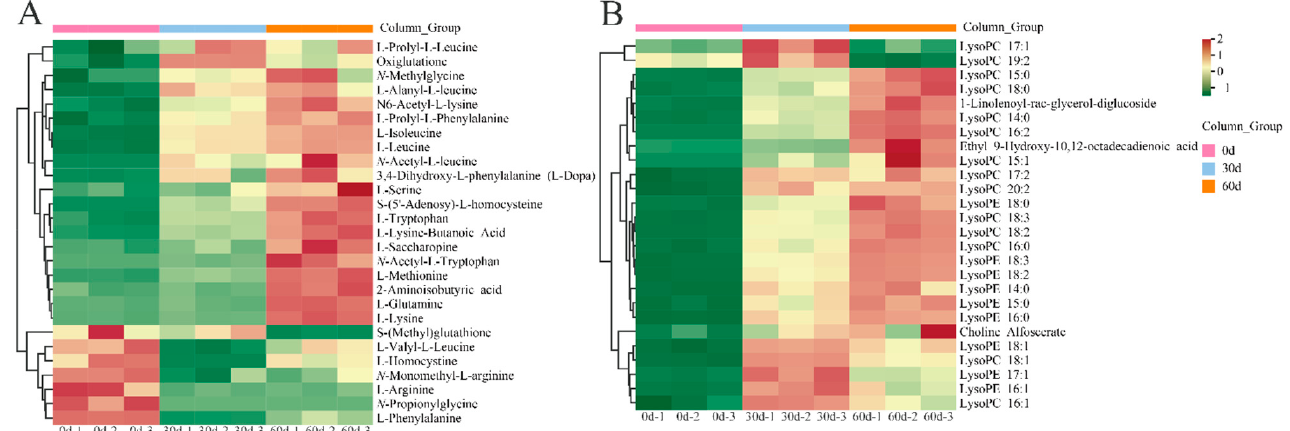
Figure 4. Heatmap of differential metabolites during storage of ‘Fengtang’ plum fruits: ( A ) Heatmap of amino acids and derivatives, and ( B ) Heatmap of lipids.